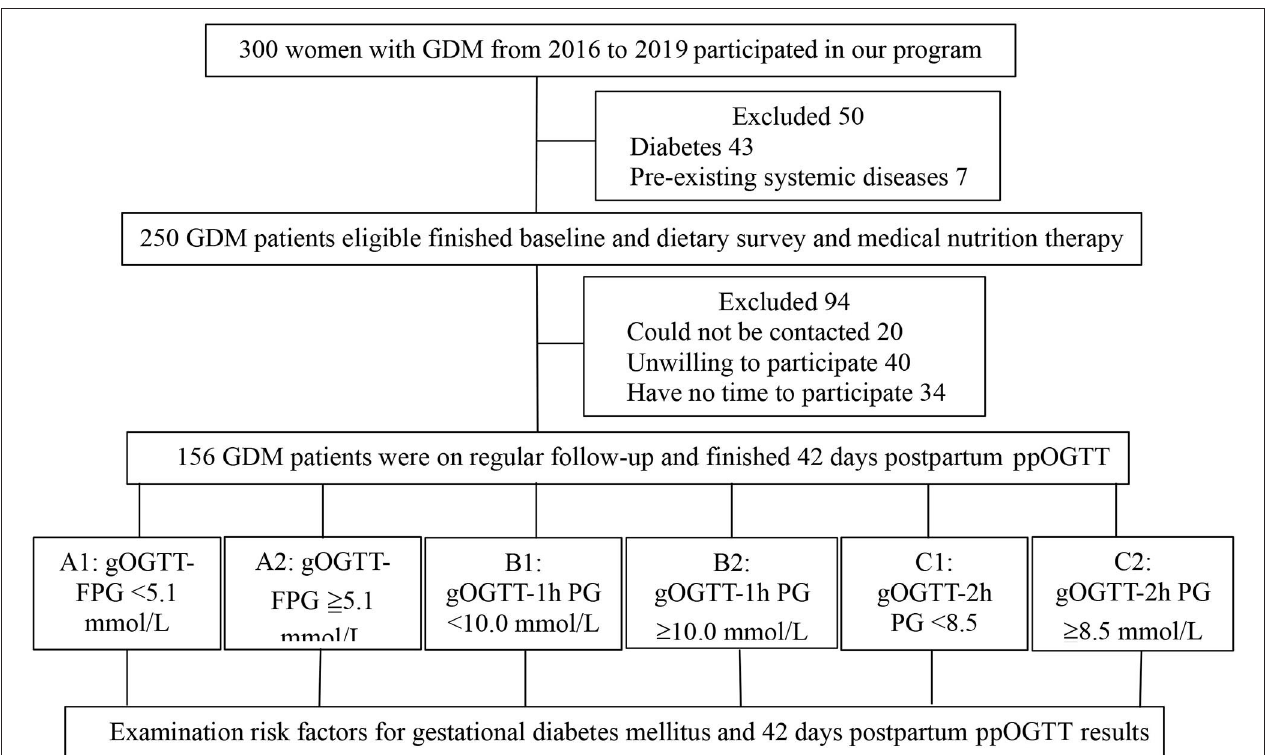
FIGURE 1 | Participants flow chart. GDM, gestational diabetes mellitus; gOGTT, gestational oral glucose tolerance test; FPG, fasting plasma glucose; 1h, 1 hour; 2h, 2 hours; PG, postprandial glucose; IFG, impaired fasting glucose; IGT, impaired glucose tolerance; DM, diabetes mellitus; ppOGTT, postpartum oral glucose tolerance